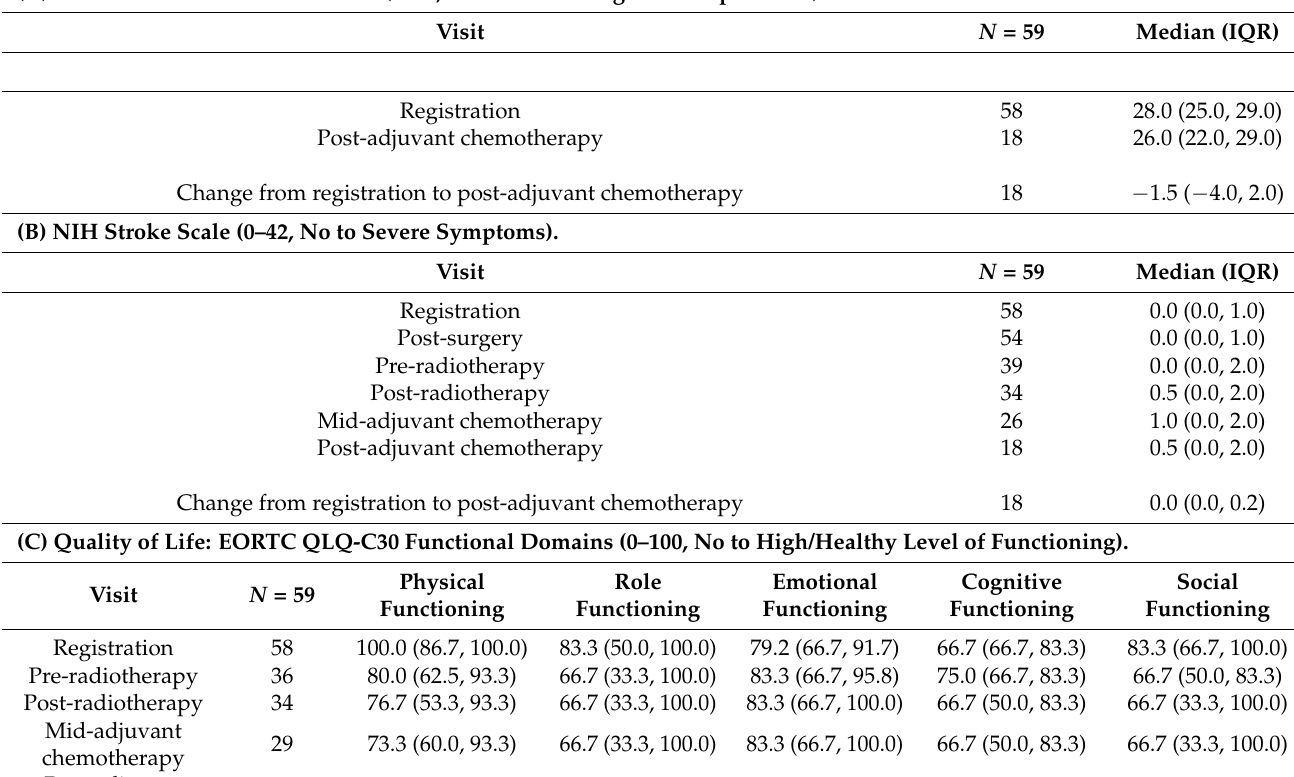
Table 3. ( A – D ) Mini-Mental State Examination ( A ), NIH Stroke Scale ( B ), and Quality of Life ( C , D )—eligible patients. (A) Mini-Mental State Examination (0–30, Severe to No Cognitive Impairment).